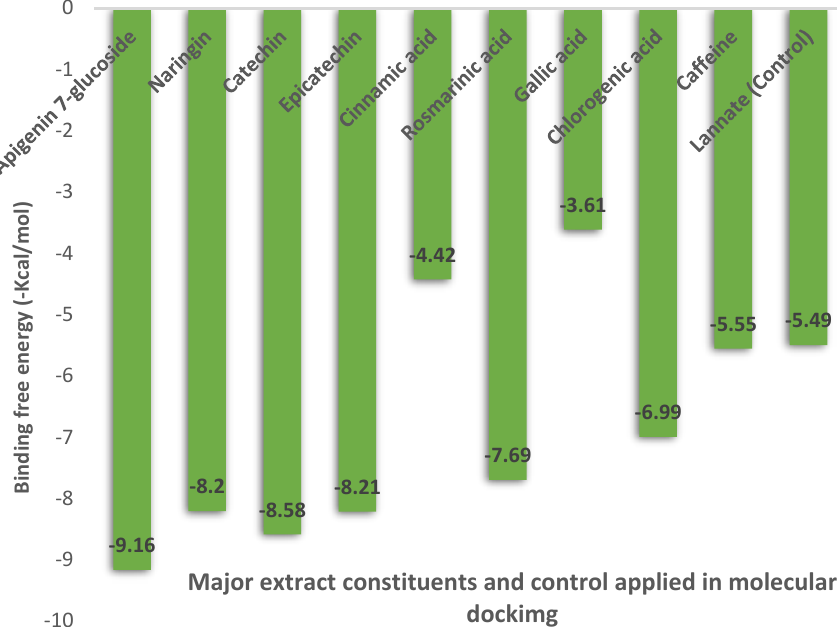
Figure 6. Binding free energy values were calculated through the molecular docking of the major constituents identified in the methanolic SCG extract and the AChE receptor.